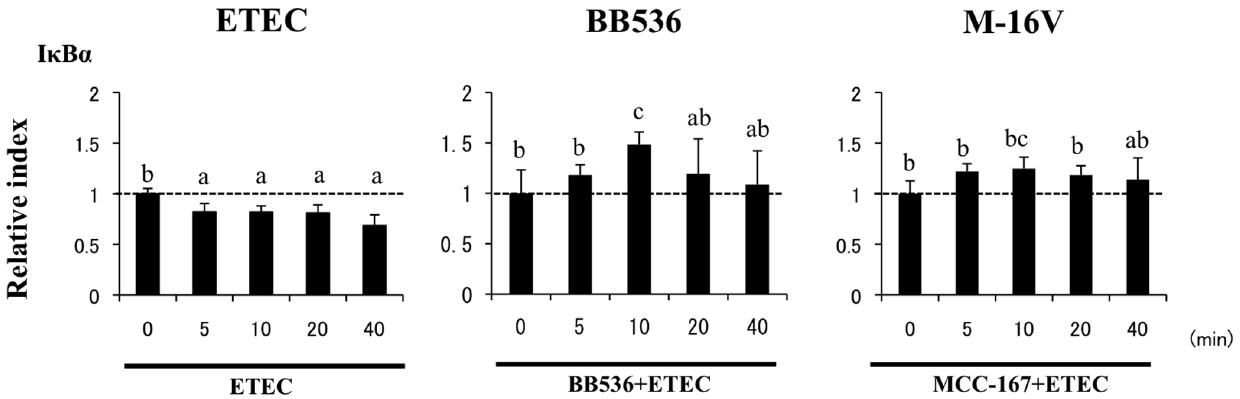
Figure 3. Western blot analysis of NF- k B pathway activation on porcine intestinal epithelial (PIE) cells after challenge with heat- stable Enterotoxigenic Escherichiacoli (ETEC) pathogen-associated molecular patterns (PAMPs). PIE cells were pre-treated with different bacterial strains for 48 h and stimulated with heat-stable ETEC PAMPs. Levels of the counter-regulatory factor I k B a were studied at the indicated times post-stimulation. Different letters indicate significant differences (P ,